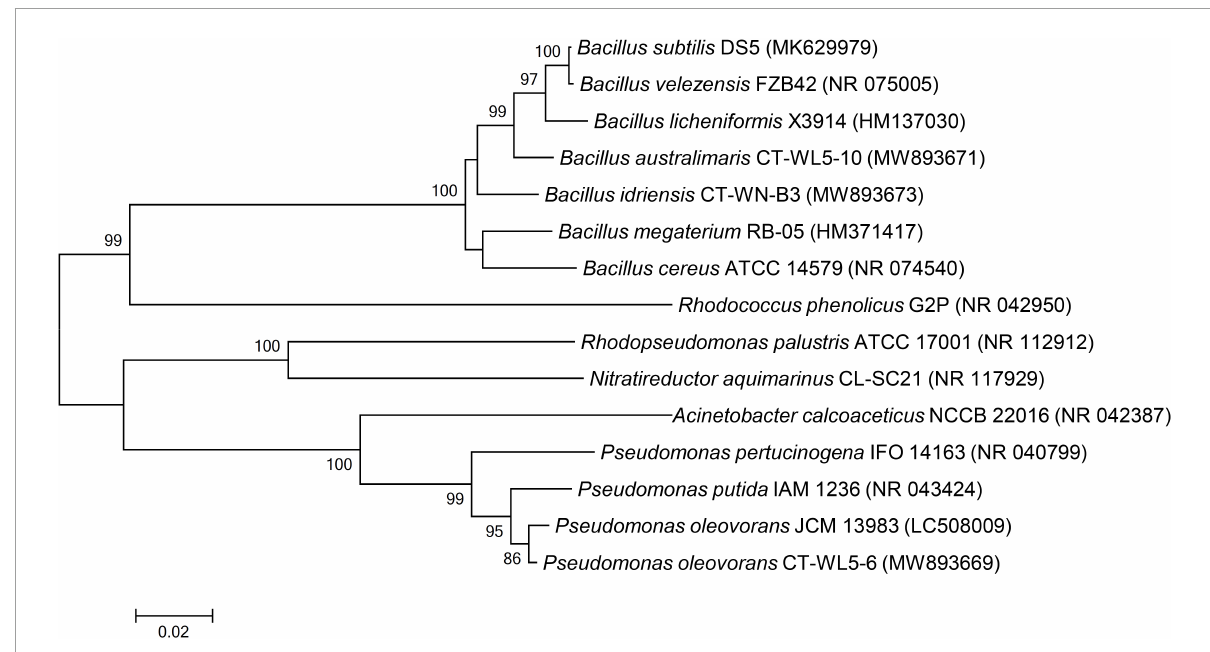
FIGURE7 Phylogenetic analysis of AN removal strains. The 16S rRNA gene sequences of the isolated strains were compared with the reported AN removal bacteria by MEGA 6.0 software, and the phylogenetic tree was constructed by the neighbor-joining method. Black circle marked the bacteria isolated in this